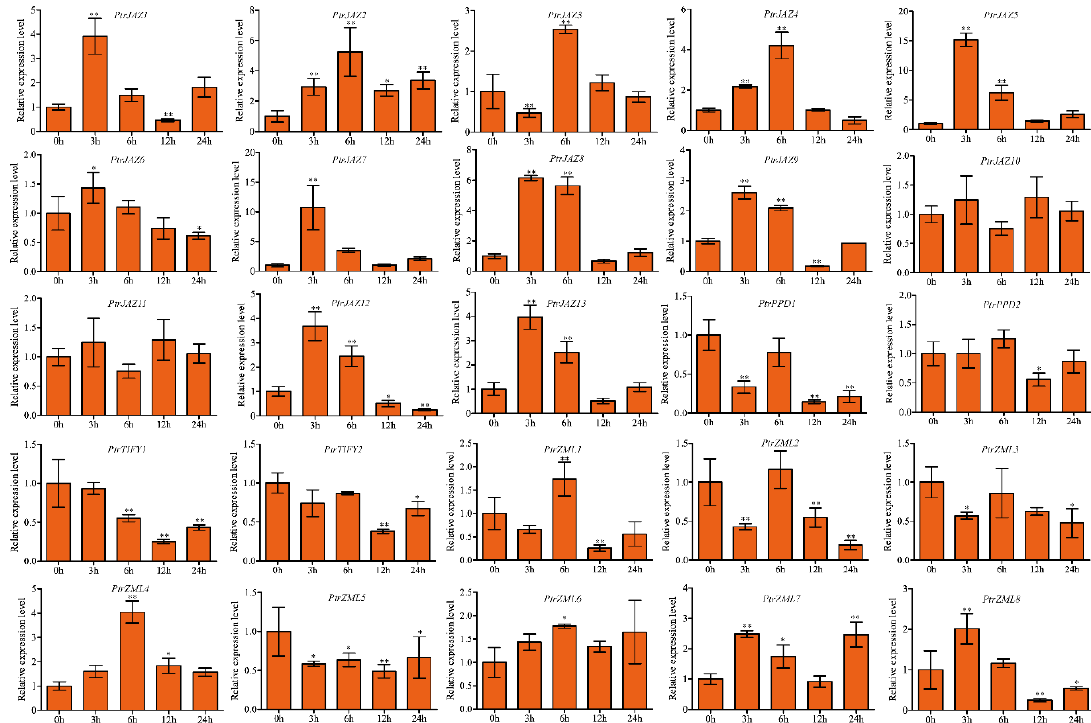
Figure 8. Expression analysis of PtrTIFY genes in root under 100 μ M MeJA treatment by qRT–PCR. Error bars represent the standard deviations from three biological replicates. Asterisks indicate stress treatment groups that showed a significant difference in transcript abundance compared with the control group (* p < 0.05, ** p < 0.01).